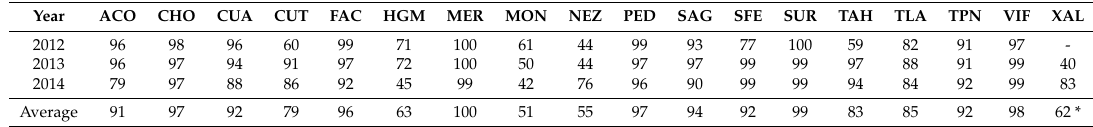
Table 1. Percentage of data available for every selected meteorological station for 2012, 2013, and 2014. In the specific case of the station XAL , the average data available were calculated considering only 2013 and